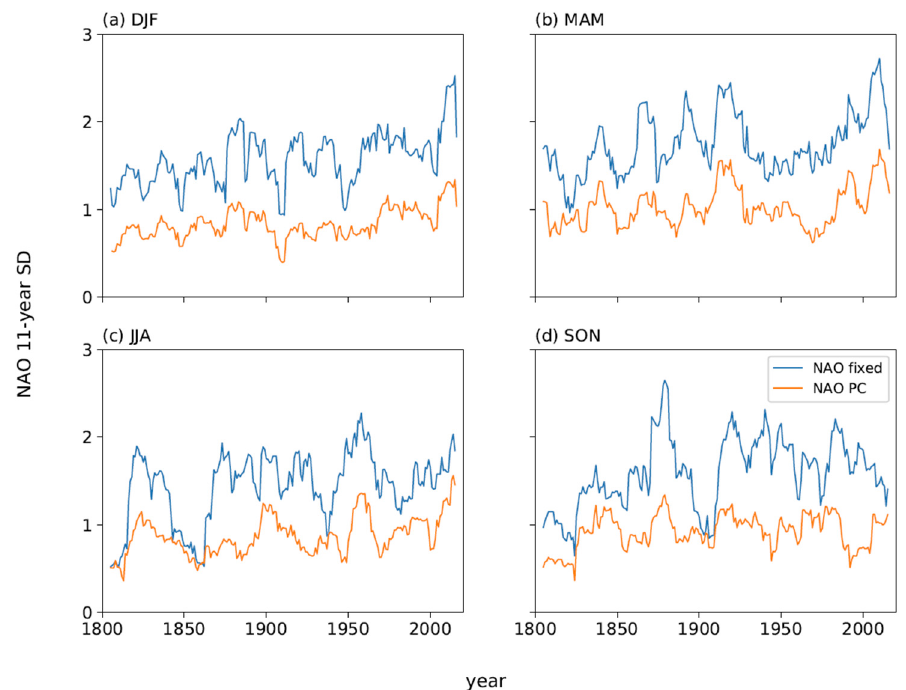
Figure 10. 11-year running standard deviation seasonal series of NAO Fixed and NAO PC for ( a ) winter (DJF), ( b ) spring (MAM), ( c ) summer (JJA) and ( d ) autumn (SON).